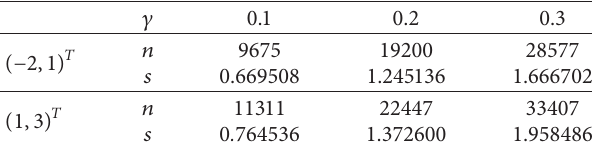
( 1 , 3 ) T . n with the initial point Table 3: Computational results for Example 2 with different c